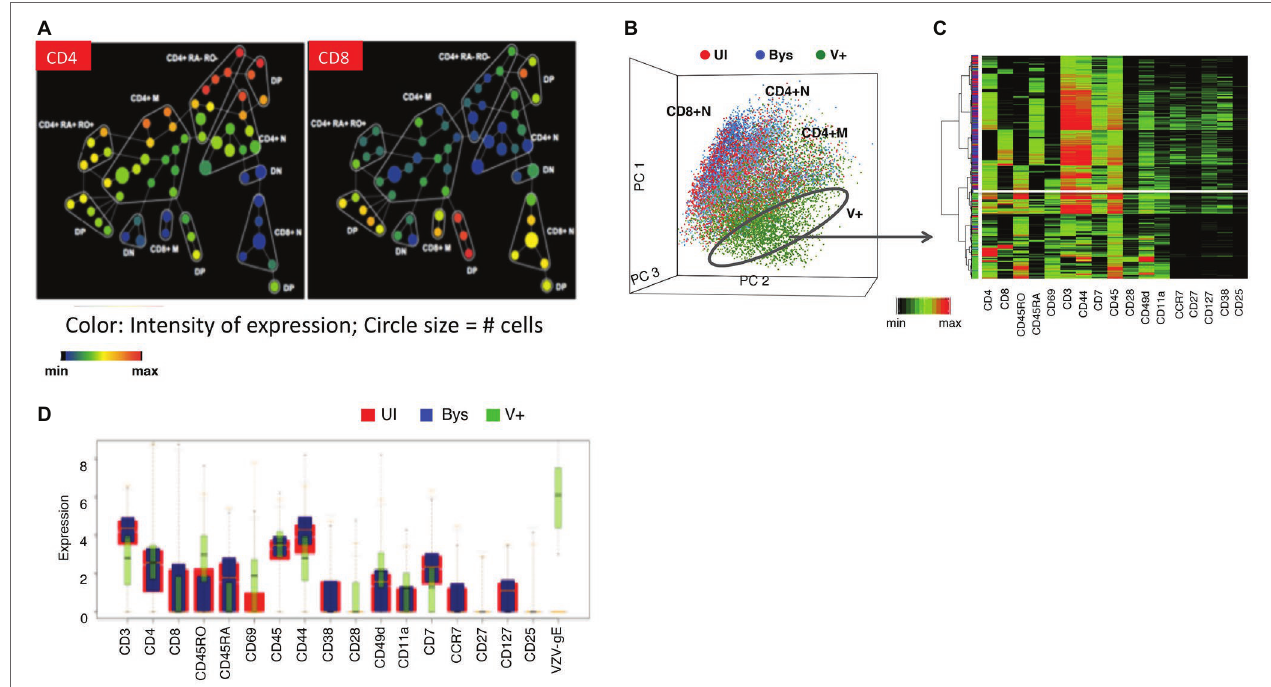
FIGURE 4 | Establishing the changes in the phenotypic hierarchy of mock-infected tonsil T cells following VZV infection. (A) SPADE tree of mock-infected T cells. The mock-infected, bystander and infected T cells were distributed by SPADE analysis tool (www.cytobank.org) into 50 nodes, each node representing a collection of cells with similar expressions of four core markers – CD4, CD8, CD45RO, and CD45RA. The size of each node correlated with the proportion of cells within each node and the color intensity is proportional to the expression of the indicated proteins; left panel shows the distribution of CD4 expression while the right panel shows that of CD8. Tonsil T cell subpopulations were highly consistent among subjects. (B) PCA of mock-infected, bystander, and VZV-infected T cells shows the distribution of the cells (each dot is a single cell) in 17-dimensional space determined by the expression of 17 surface markers evaluated in this analysis. The mock- infected cells (red dots) and bystander cells (blue dots) showed a neat overlap being distributed into three main cell clouds consistent with CD4 + memory, CD4 + naïve, and CD8 + naïve cells. The VZV-infected cells (green dots) on the other hand occupied a distinct niche on the PCA plot. (C) Agglomerative hierarchical clustering of the cells, shown as a heatmap, clusters the VZV-infected cells distinctly from the mock-infected and bystander cells, which show overlapping distribution. (D) The box plots show the differential expression of the individual surface proteins between the mock-infected (red) and VZV-infected (green) cells. Adapted from Sen et al.